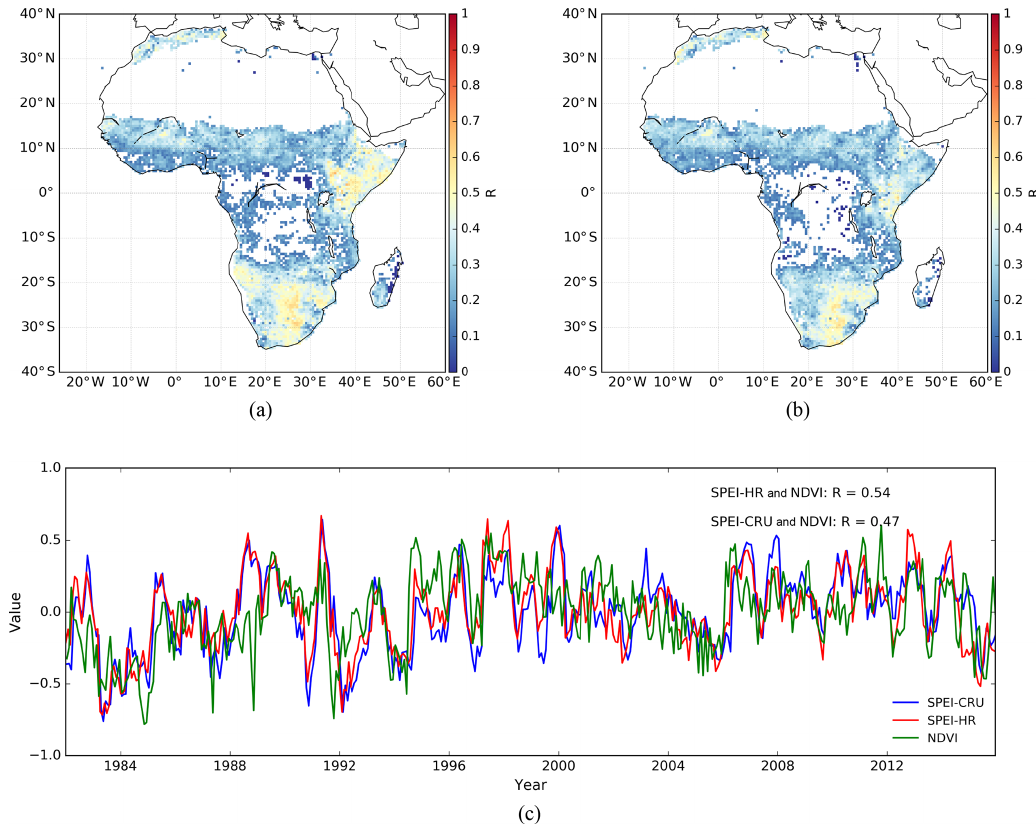
Figure 5. Spatial maps of the correlation between SPEI and NDVI for 6-month SPEI: (a) SPEI-HR and (b) SPEI-CRU. The time series of area mean NDVI and SPEI are shown in (c) , where R refers to the correlation coefficient. The correlations shown here are all significant at the 95% confidence level. Table 3. The correlation ( p < 0 . 05) between area mean NDVI and SPEI at different timescales. SPEI-01 SPEI-03 SPEI-06 SPEI-09 SPEI-12 SPEI-24 SPEI-36 SPEI-48 R (SPEI-CRU) 0.23 0.42 0.47 0.20 R (SPEI-HR)